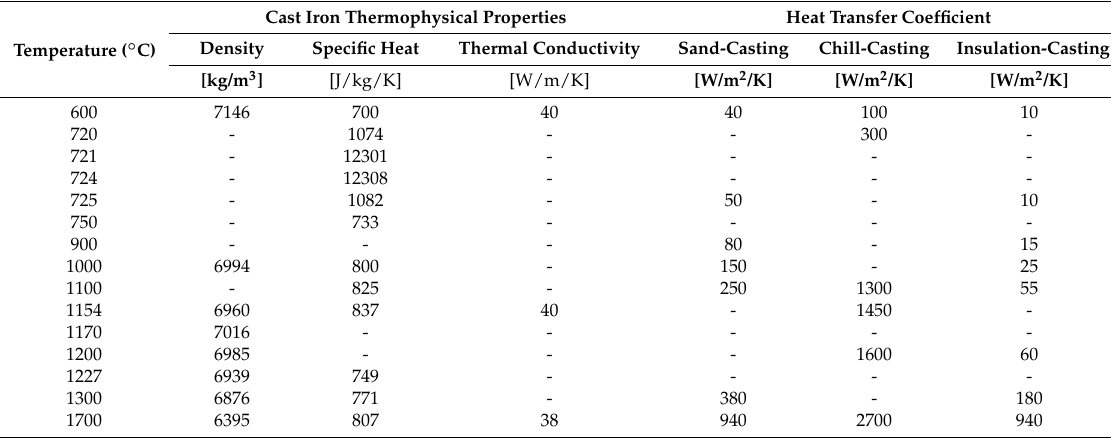
Table 2. Temperature dependent properties of the cast iron and heat transfer coefficients *. fraction of primary austenite ( f γ ) for each alloy: 0.3 for alloy A, 0.4 for alloy B, 0.51 for alloy C, and 0.61 for alloy D [16]. Temperature ( ° C)